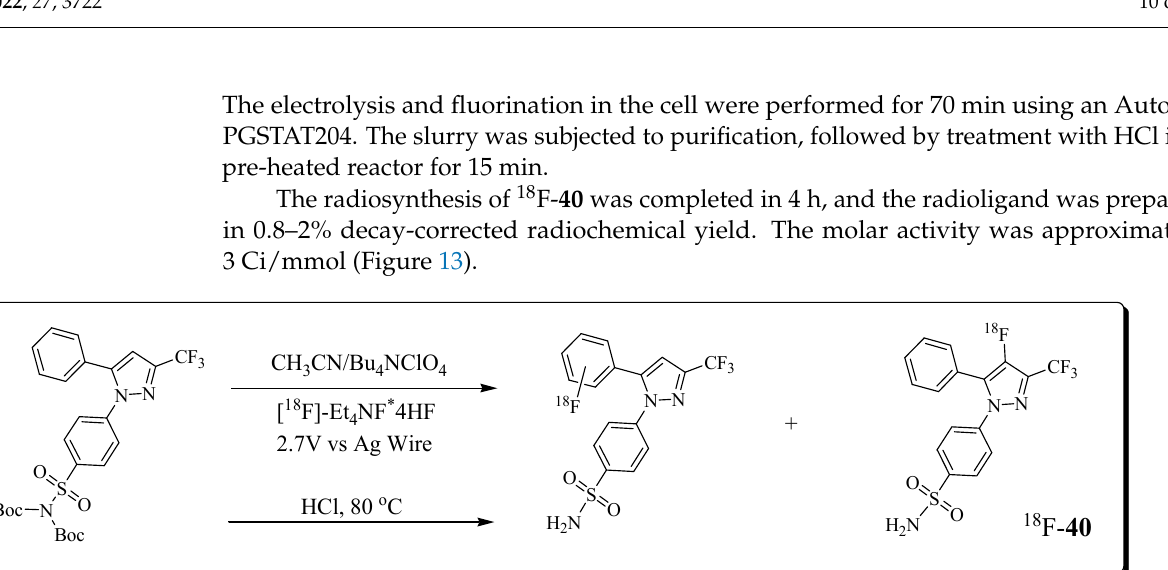
Figure 13. The reaction scheme of the electrochemical radiosynthesis of COX-2 inhibitor 18 F- 40 . RAW264.7 macrophage-like cells. A reduction of radioligand uptake was detected when